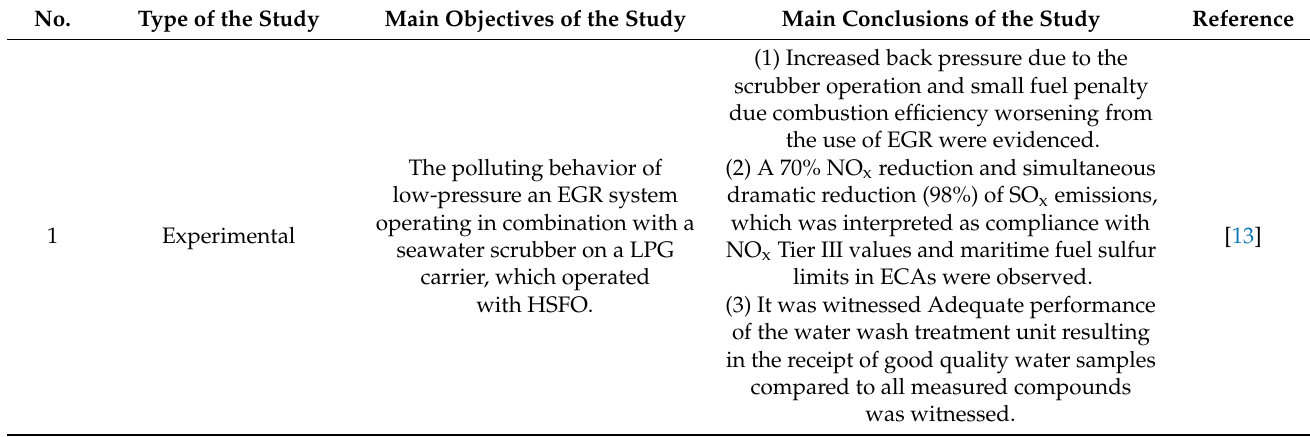
Table 3. Consolidation of the results of the literature review on marine exhaust gas treatment systems. For each study examined in the literature and listed in this table its type (experimental, theoretical or review), its main objectives and its main conclusions are shown along with its